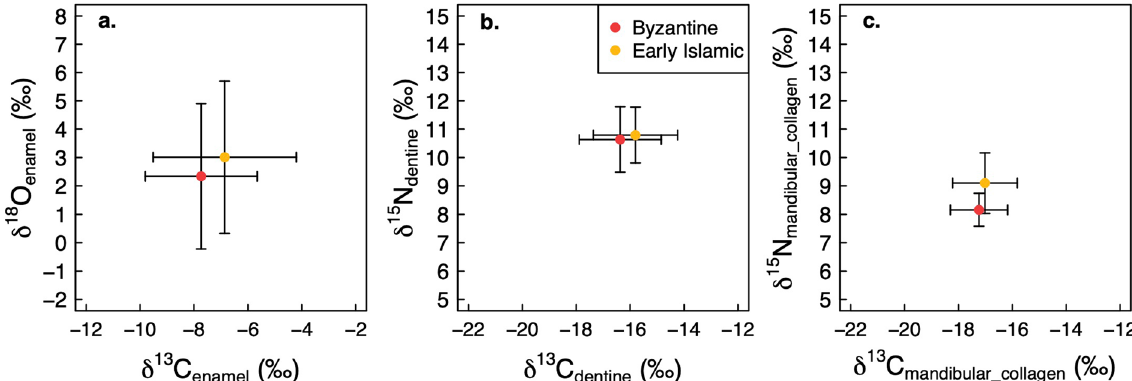
Figure 5. Stable isotopic measurements from each archaeological proxy (enamel carbonate, tooth dentine and mandibular collagen) divided into chronological phases. ( a ) δ 13 C enamel vs. δ 18 O enamel , ( b ) δ 13 C dentine vs. δ 15 N dentine , ( c ) δ 13 C mandibular collagen vs. δ 15 N mandibular collagen .